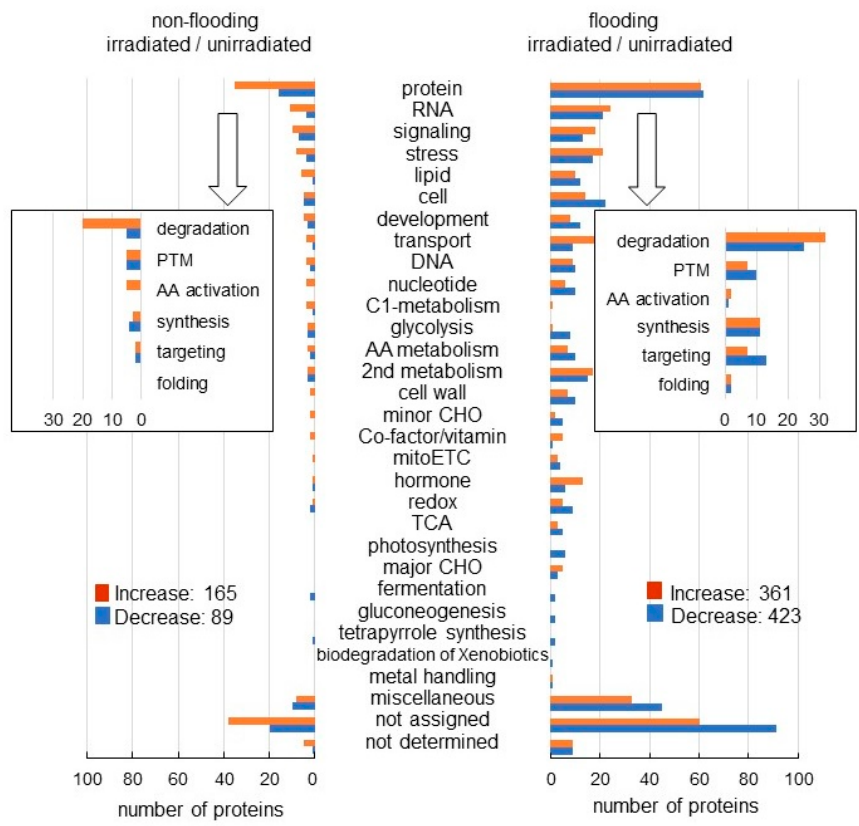
Figure 2. Functional categories of proteins with differential abundance in wheat irradiated with millimeter waves with or without flooding stress. Wheat seeds were irradiated without (unirradiated) or with (irradiated) 20 mW of millimeter waves for 20 min and exposed without (non-flooded) or with (flooded) flooding stress. Non-flooded and flooded samples were collected from both the unirradiated group and the irradiated group. After proteomic analysis, functional categories of significantly changed proteins ( p < 0.05) from irradiated/unirradiated wheat without or with flooding stress were determined using MapMan bin codes (Tables S2 and S3). Orange color indicates “increased proteins” and blue color indicates “decreased proteins” in irrigated wheat compared with unirradiated wheat. Abbreviations: mitoETC, mitochondrial-electron transport chain; TCA, tricarboxylic-acid cycle; PTM, post-translational modification; and AA, amino acids. “not assigned” indicates proteins without ontology or characterized functions.